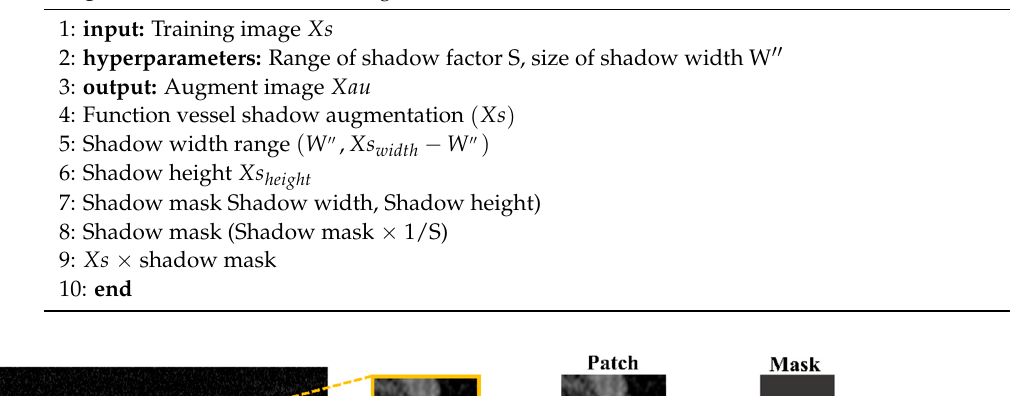
Algorithm 1. Vessel Shadow Augmentation